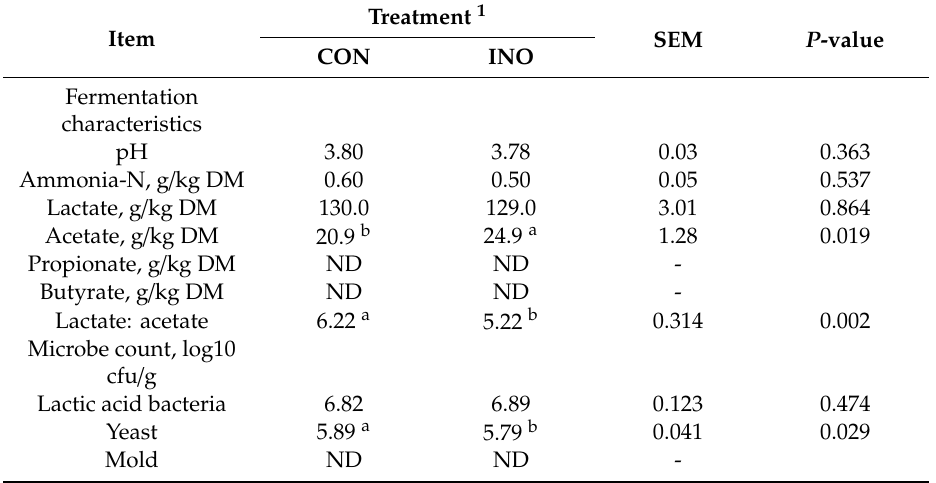
Table 5. E ff ects of new inoculant on fermentation characteristics and microbial count of corn silage ensiled for 72